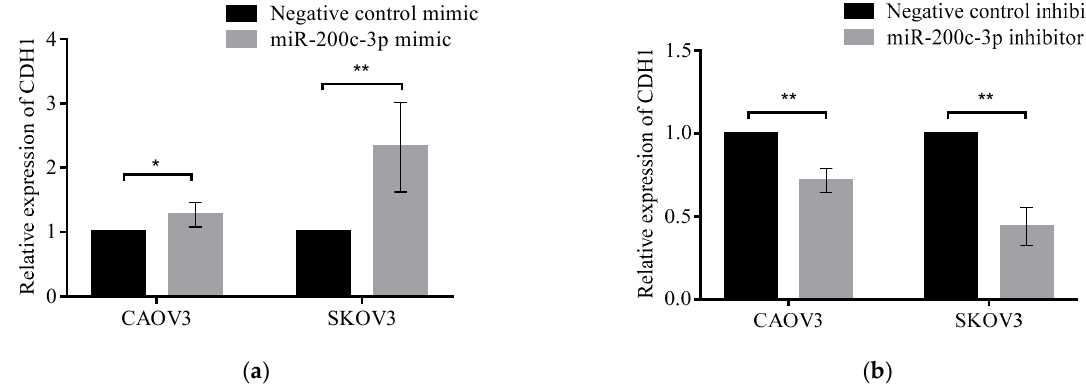
Figure 5. The expression level of EMT/MET markers detected by quantitative real-time qRT-PCR in HGSC cell lines. ( a ) The CAOV3 and SKOV3 cells transfected with miR-200c-3p mimic showed a significantly increased expression level of CDH1 . ( b ) Following transfection with miR-200c-3p inhibitor, there was significant downregulation of CDH1 expression. Significant values are indicated as follows: * p < 0.05 and ** p < 0.01.